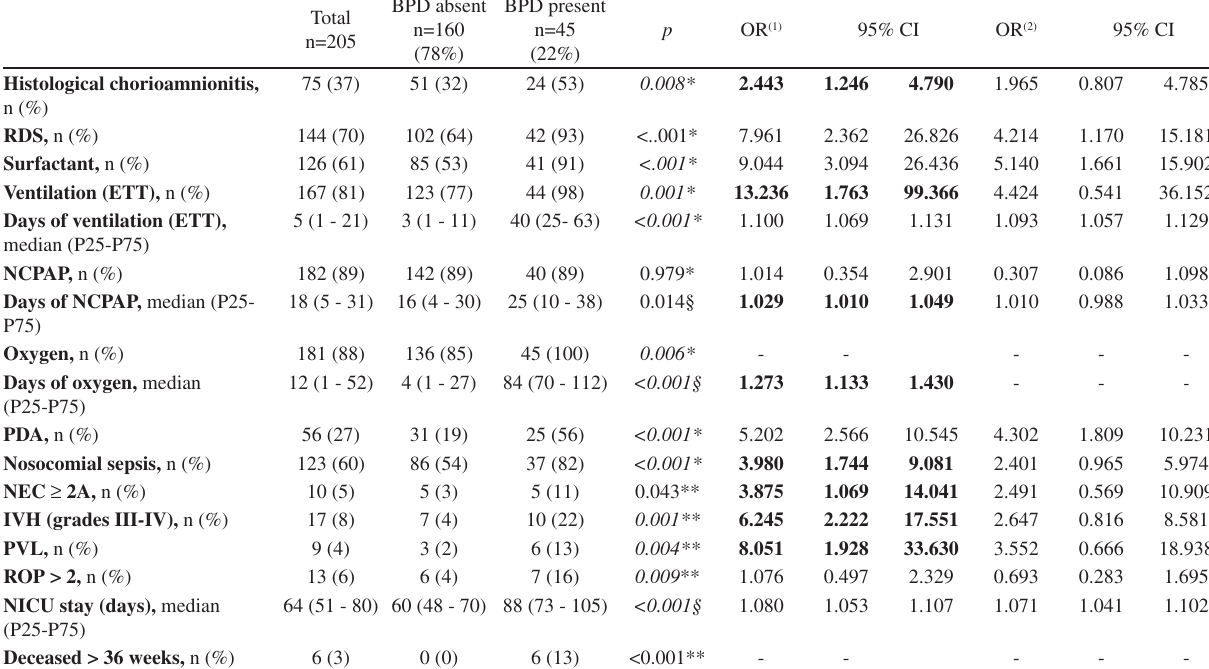
Table 2 - Clinical characteristics of the studied population